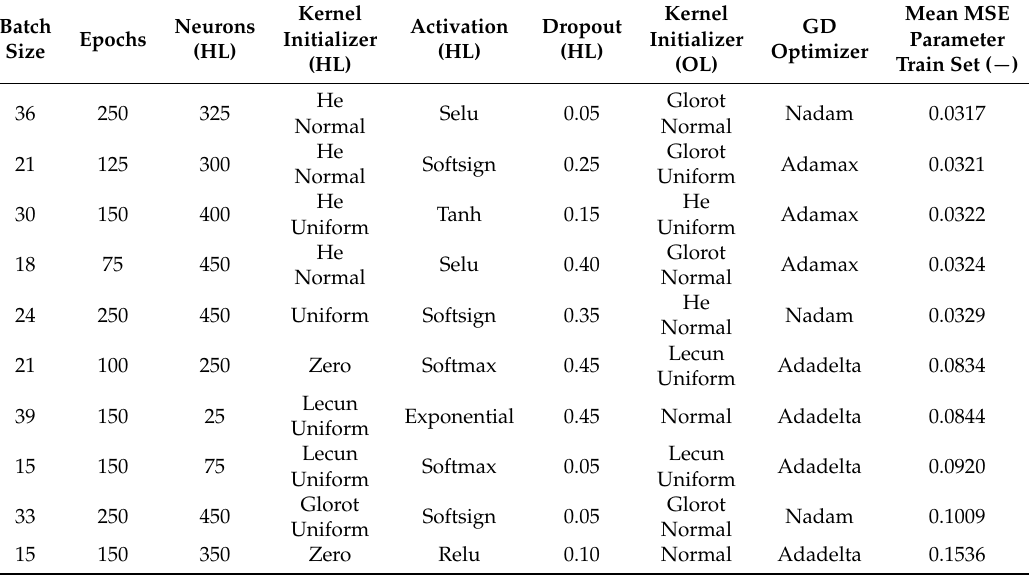
Table A6. Five best and worst randomsearch training results and respective hyperparameters.